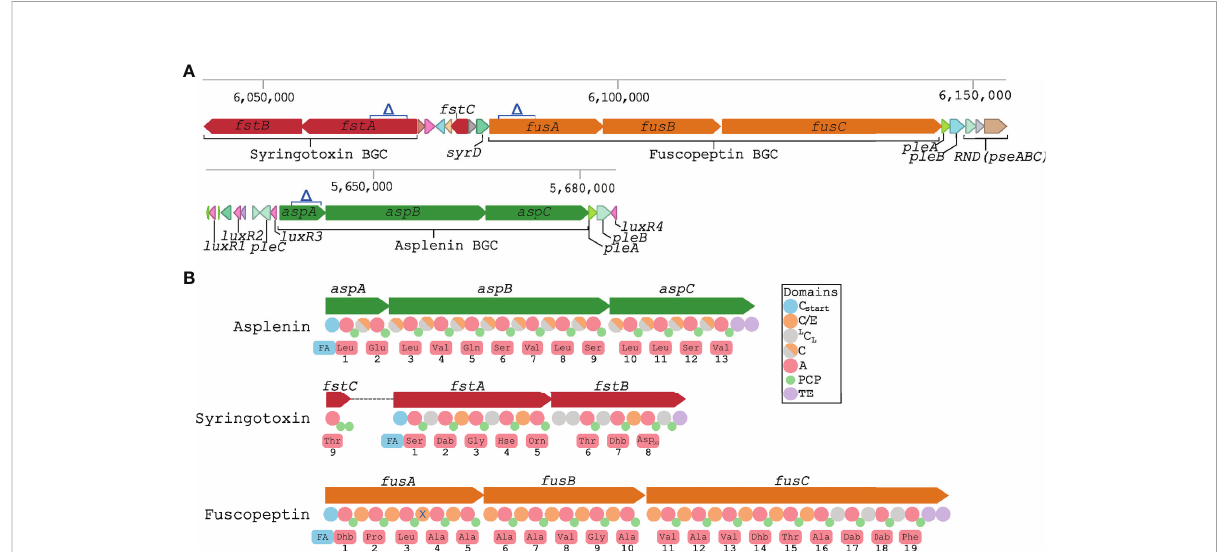
FIGURE 1 Biosynthetic gene clusters encoding CLPs in P. f uscovaginae UPB0736. (A) Schematic representation of the predicted syringotoxin, fuscopeptin and asplenin NRPS BGC and the associated genes. D indicates the deletion in the constructed CLP mutants. Putative transporter genes pleA, pleB, pleC, syrD, pseABC and luxR -type regulatory genes are also indicated. (B) Predicted NRPS domains and adenylation domain amino acid substrate prediction for asplenin, syringotoxin and fuscopeptin synthetases. Predictions were based on phylogeny-based substrate prediction (Figure S1 – S3). A, adenylation: PCP, peptidyl carrier protein; TE, thioesterase. C start , lipoinitiation: L C L , regular condensation; C/E, condensation/ epimerization; C, condensation (epimerization data not available). X: non-functional